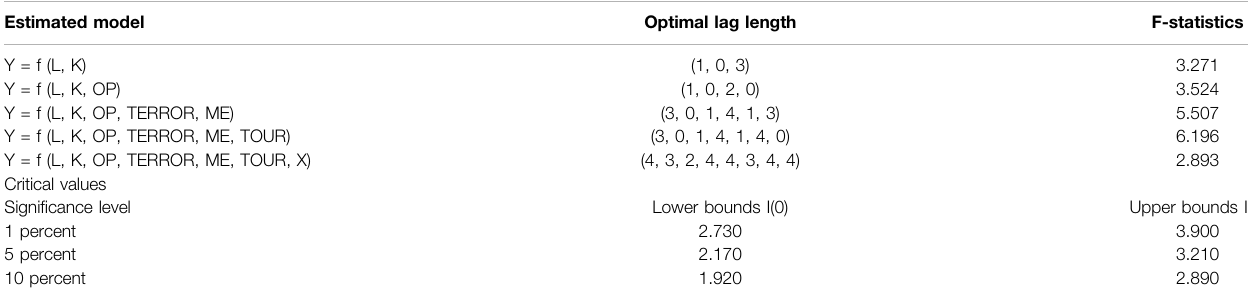
TABLE 5 | ARDL Bound Cointegration. Estimated model